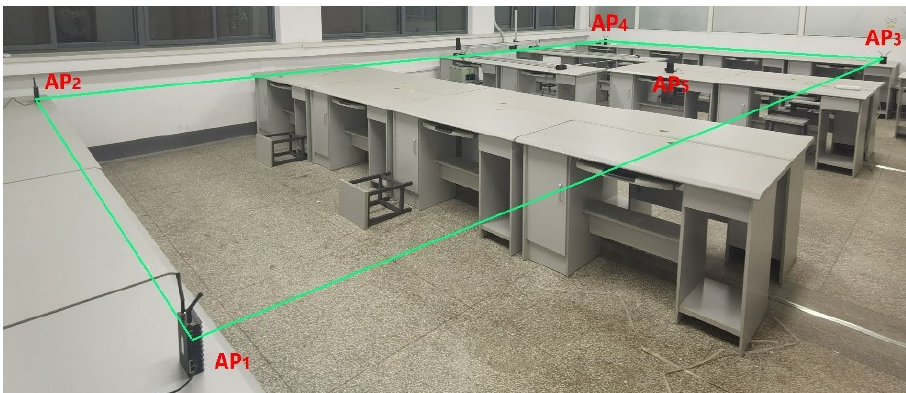
Figure 4. Diagram of the indoor test environment and APs deployment.